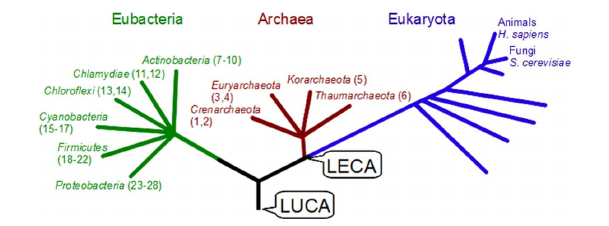
Figure 1 | Phylogeny of compared species. The generalized phylogeny of the three superkingdoms studied, adapted from (Woese et al., 1990). Numbers in parentheses relate to full species names and taxonomy given in Supplemental Table S1 . LECA, last eukaryotic common ancestor. LUCA, last universal common